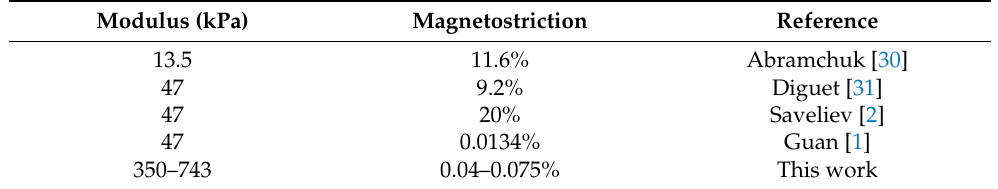
Table 4. Selected studies investigating the magnetostriction of MRE along with the storage modulus